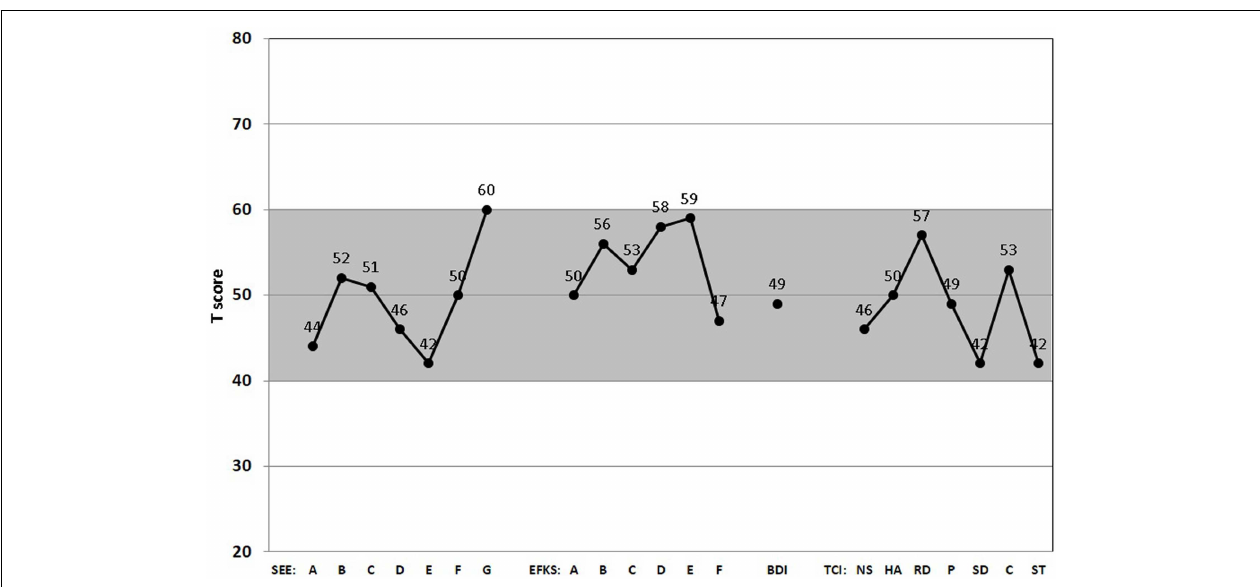
recognizing and understanding one’s emotions; B, recognizing emotions in others; C, regulation and control of one’s emotions; D, emotional expressivity; E, regulation of the feelings of others; F, adjustment to feelings), BDI-II, and TCI (NS, novelty seeking; HS, harm avoidance; RD, reward dependence; P, persistence; SD, self-directedness; C, cooperativeness; ST, self-transcendence) are presented. (Gray-shaded area depicts the normal